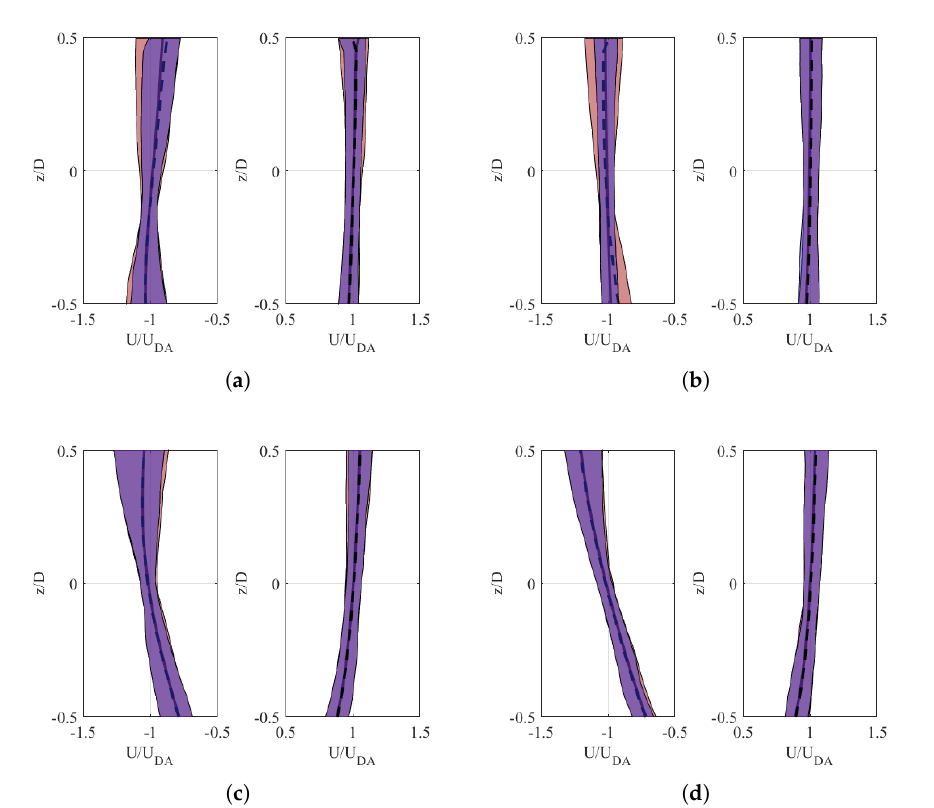
Figure 5. Range of shear profiles for one flow speed case, at two different location and and two hub heights, near surface with an origin at z hub = − 15 m and near bed with an origin at z hub = − 28 m, for varying measured profiles (red band), without waves (blue band), mean measured (dashed black) and mean with waves (solid black). ( a ) Near Surface, Location A. ( b ) Near Surface, Location B. ( c ) Near Bed, Location A. ( d ) Near Bed, Location